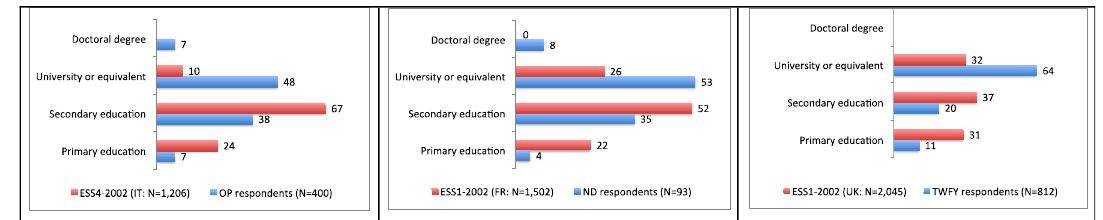
Figure 1: Educational attainment of respondents vs. their respective country populations